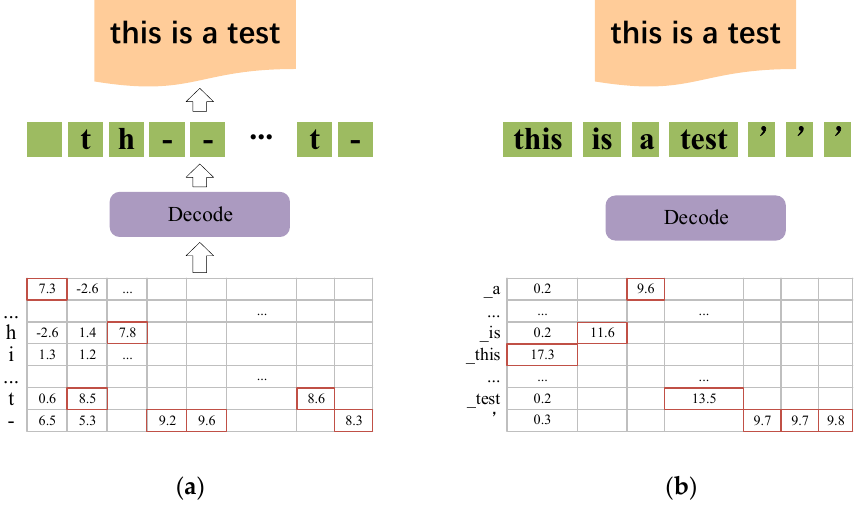
Figure 2. The schematic diagram of sparse logits ( a ) and dense logits ( b ).